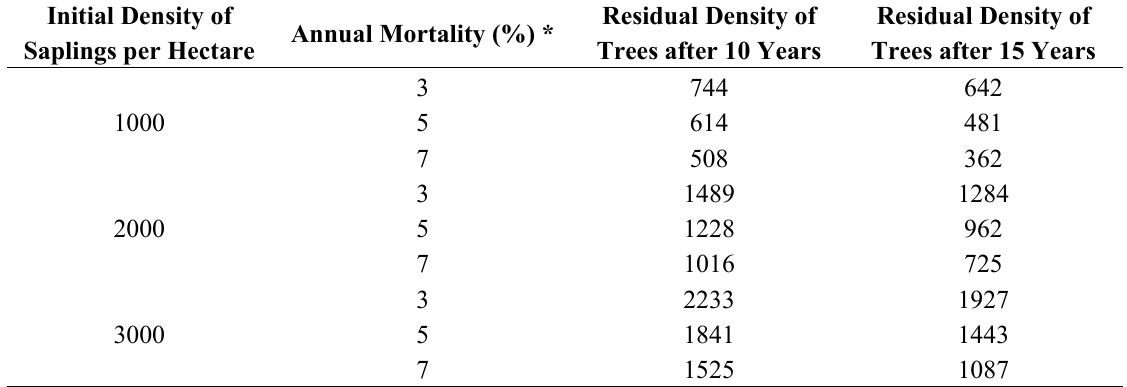
Table 6. Effects of different rates of annual mortality on initial densities of saplings and development into trees over 10 and 15 years. Initial Density